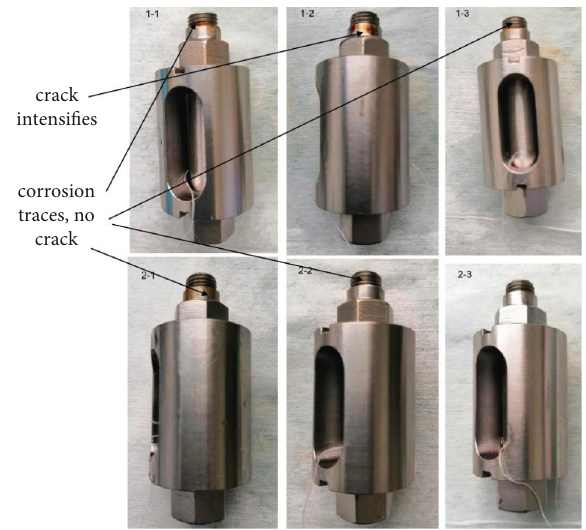
Figure 12: The surface condition of the test piece soaked in boiling magnesium chloride solution for 12 h.